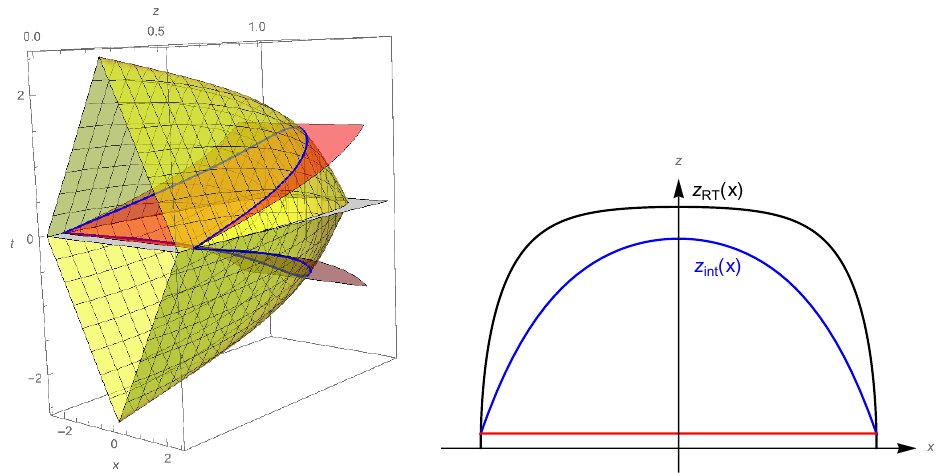
Figure 3 . Region relevant to the action computation for a segment in the BTZ case, for l = 5. Left: intersection of WDW patch with entanglement wedge in the ( x; z; t ) space. The boundary of the entanglement wedge is in yellow, while the boundary of the WDW patch is in red. Right: intersections in the ( x; z ) plane, with z RT in black, z int in blue and the cuto(cid:11) z = " in